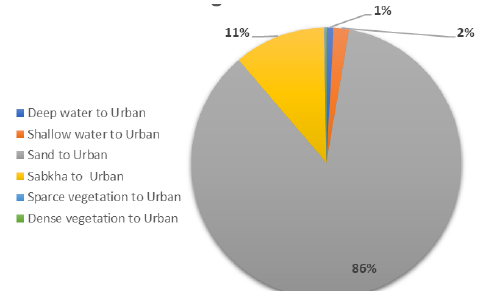
Figure 7: Growth of Urban class in study area from 1990 to 2022 with respect to other classes 3.3 Urban Cover Change 3.3.1 Quantification : To accurately measure and represent Figure 5: Urban/Non-Urban maps in Abu Dhabi from 1990 to 2022.